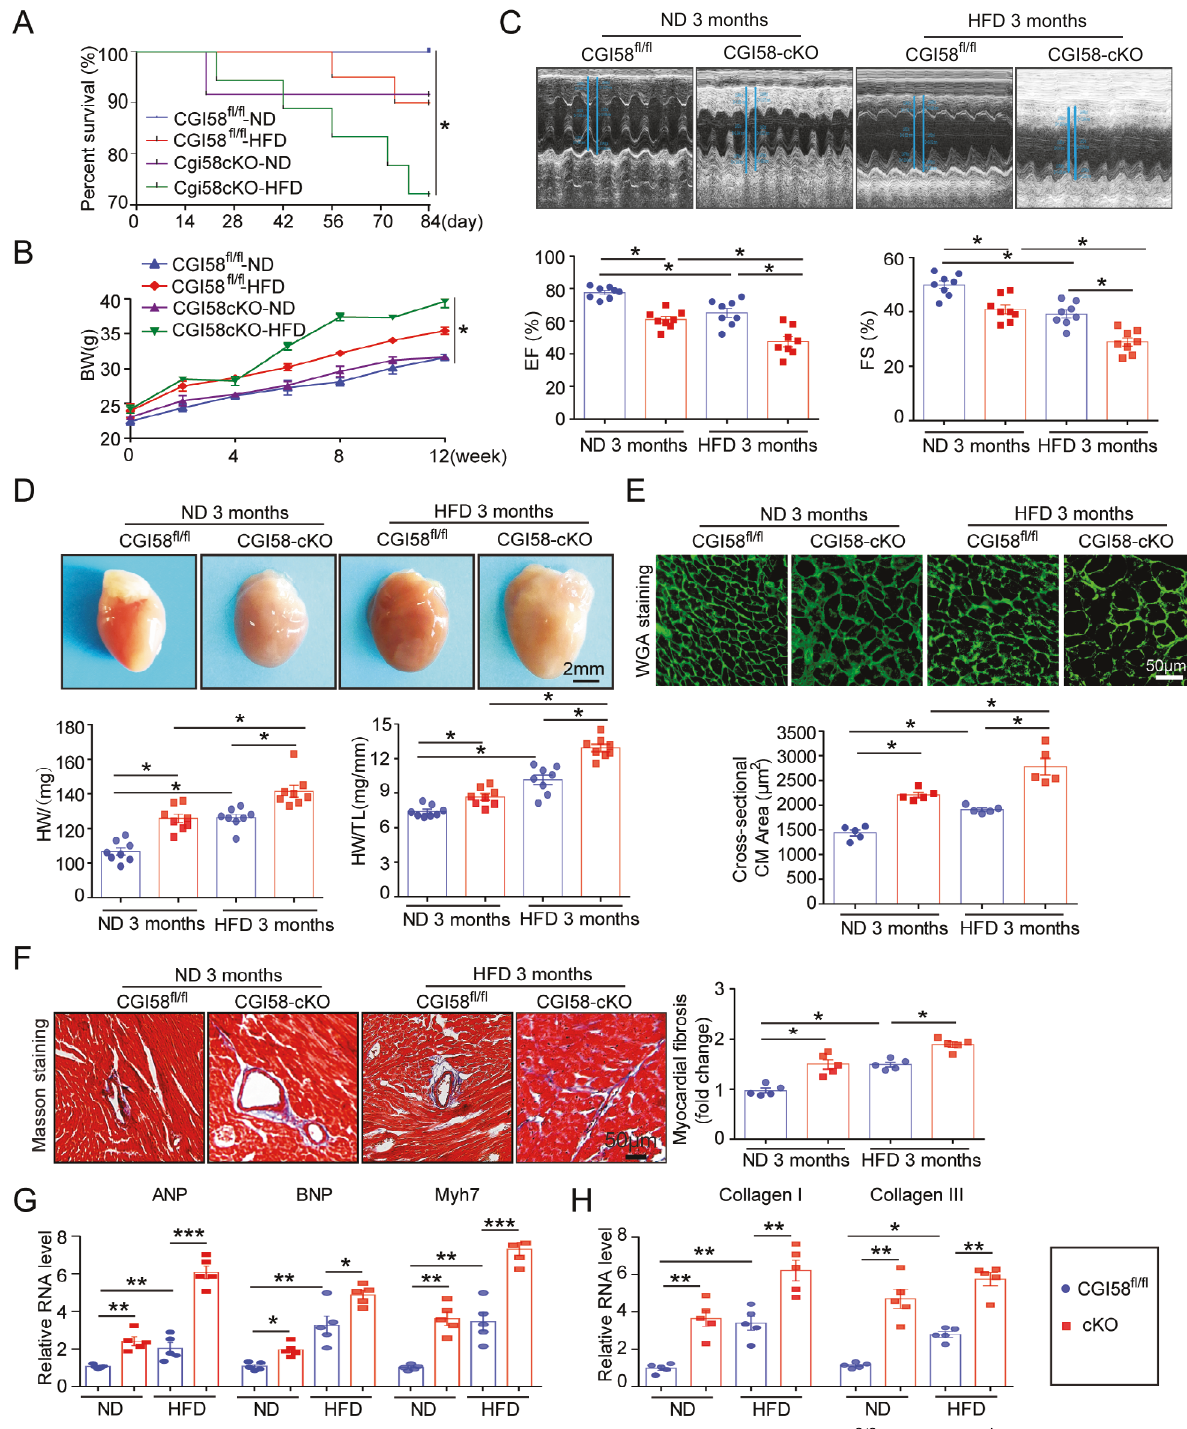
Fig. 1 CGI-58-de fi cient mice develop cardiac hypertrophic remodeling and dysfunction. CGI-58 fl / fl and CGI-58 cko mice were fed with ND or HFD for 3 months. A , B The survival rate and body weight of CGI-58 fl / fl and CGI-58 cko mice ( n = 10). C M-model echocardiography of the left ventricle (upper). Measurement of ejection fraction (EF%) and fractional shortening (FS%) (lower, n = 8). D Heart size (upper), heart weight, and heart weight to tibia length (HW/TL) ratio (lower, n = 8). Scale bar 2 mm. E Wheat germ agglutinin (WGA) staining of heart sections (upper) and the quanti fi cation of cardiac myocyte size (lower). Scale bar 50 μ m ( n = 5). F Masson ’ s Trichrome staining of heart sections (upper) and the quanti fi cation of the relative fi brosis area (lower, n = 5). G , H qPCR analyses of ANF , BNP, Myh7 , collagen I and collagen III mRNA levels ( n = 5). Data are presented as mean ± SEM, and n represents the number of animals per group. * P < 0.05, ** P < 0.01, *** P <